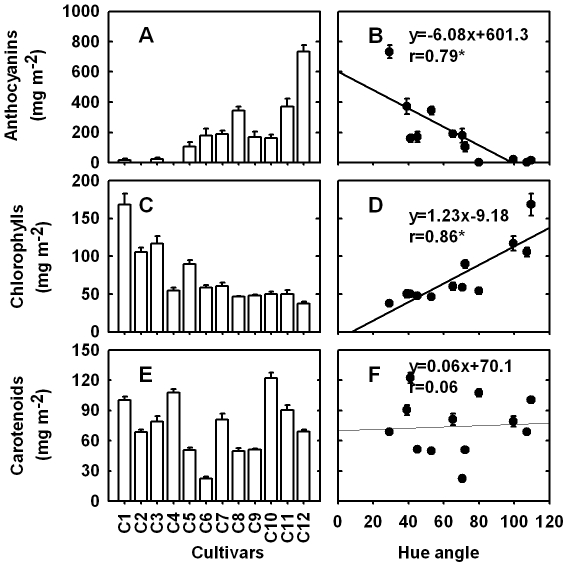
Concentrations of anthocyanins (A), chlorophylls (C), and carotenoids (E) and their correlations with hue angle (B, D, F) in the pericarp of twelve litchi cultivars.Each point is mean ± standard error (n = 15). C1 to C12 are different cultivars explained in Figure 1. Relative coefficient r with ‘*’ indicated significantly correlated at the level of P<0.05.